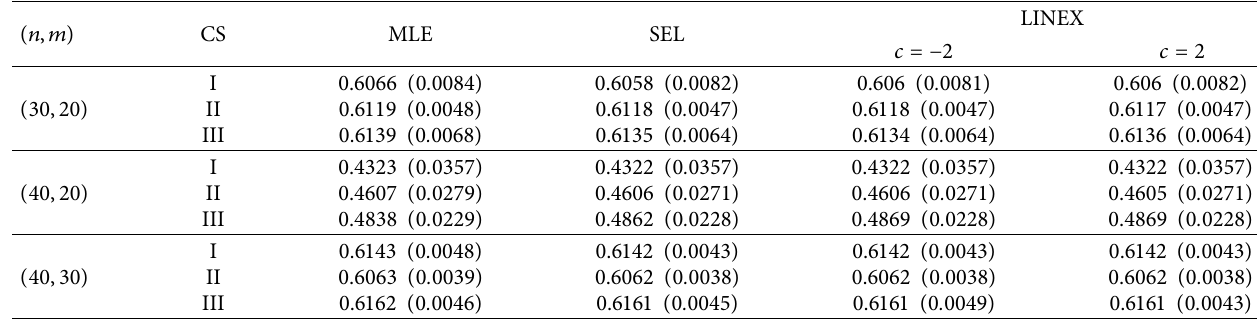
Table 7: MSE of ML and Bayesian estimates for the S ( t ) with t � 0 . 4.